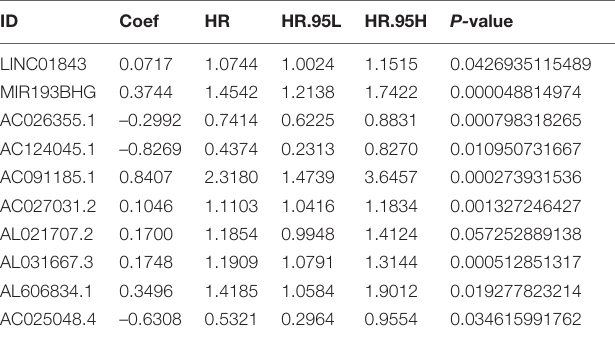
TABLE 2 | Ten ferroptosis-associated lncRNAs determined via multivariate Cox regression